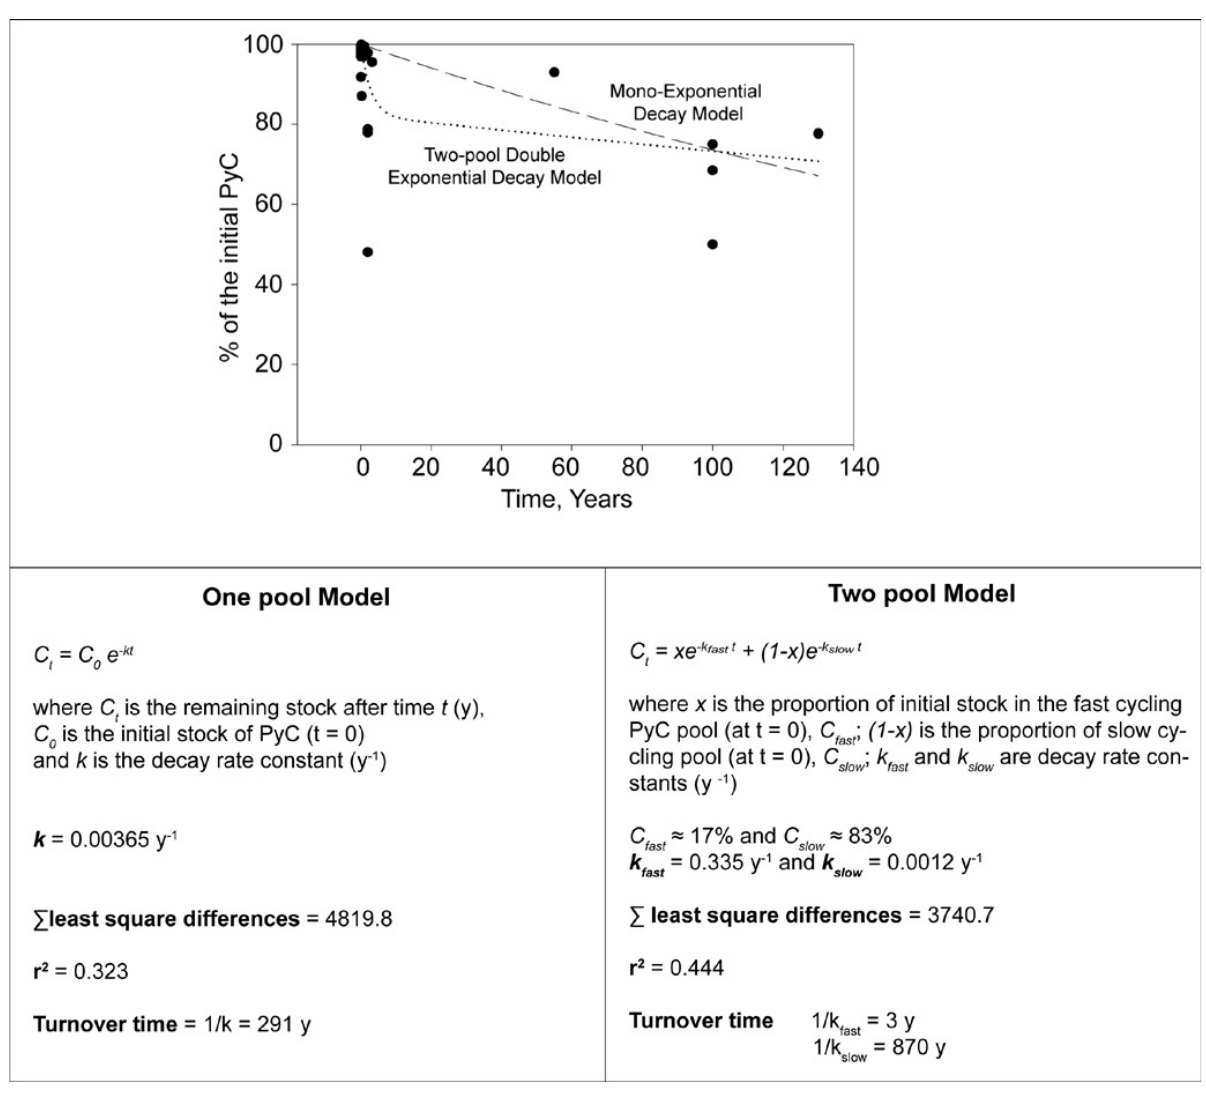
Fig. 1. Parameter estimates for the one-pool exponential and the two-pool exponential